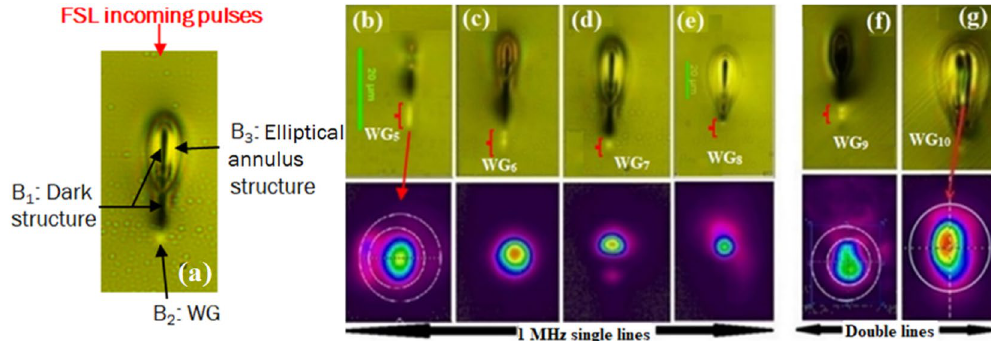
Figure 5. ( a ) 20 × Bright field microscopy image illustrating the structural features of the single line FSL modified region (1 MHz PRF, 150 nJ pulse energy). The dark structure B 1 is the focal volume. B 2 below B 1 is the WG due to its strong guiding capability. B 3 around the upper end of B 1 is elliptical-shaped annulus structure which comprises of varying index layers. The red arrow indicates the direction of FSL incoming pulses. ( b – e ) 20 × Brightfield microscopy structural features (cross-section) of : ( b – e ) single line FSL modified regions (cross- sectional view in top row) with pulse energies varying from 50 to 200 nJ with 50 nJ intervals with the resulting WGs sequentially named as WG 5 -WG 8 , and ( f – g ) double line FSL modified regions with 100 nJ and 200 nJ pulse energies with guiding structures referred to as WG 0 and WG 10 , respectively. The 2nd row represents the corresponding 1550 nm beam profiles of the WGs in the strong guiding structures below B 1 .